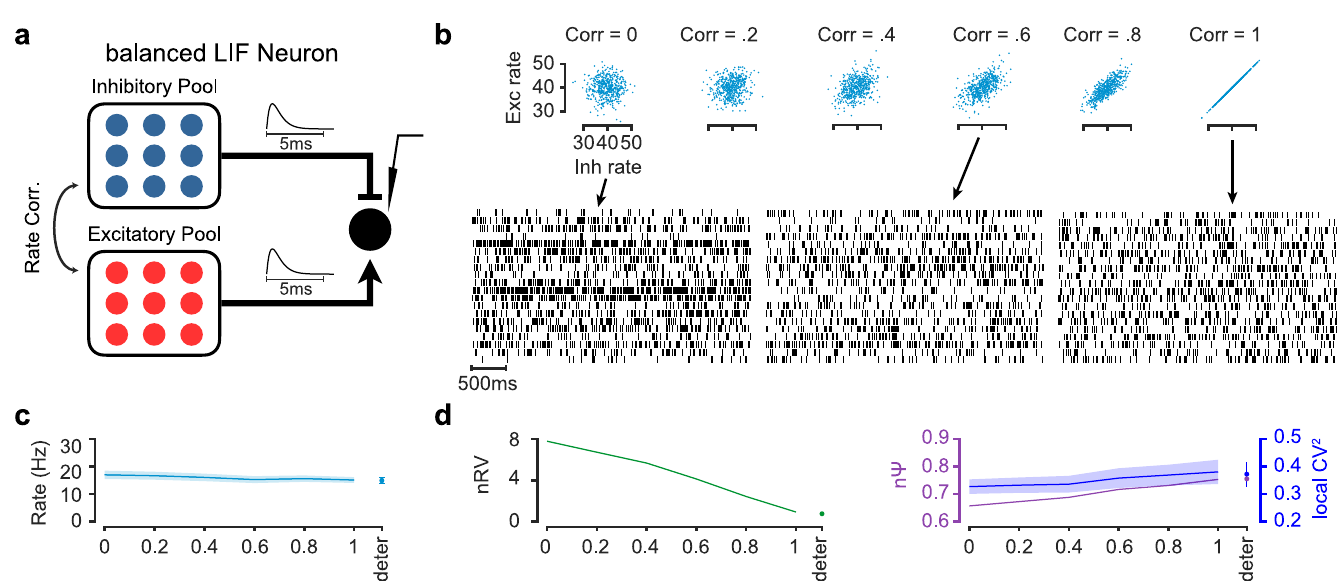
Fig 7. Firing rate correlation between balanced presynaptic excitatory and inhibitory pools controls post-synaptic nRV. (a) Schematic of the network model including 50 Excitatory (E pool) and 50 Inhibitory (I pool) Poisson neurons. The synaptic current is modeled using the same kernel for E and I connections. (b) E/I rate distributions of different trials (~ N (40,4)) with different correlation values (top) along with simulated sample rasters in three correlation conditions (correlations equal to 0, 0,6 and 1). (c) The effect of E/I rate correlation on the firing rate of post synaptic neuron. (d) The effect of E/I rate correlation on the nRV (left) and n C (right) of the post synaptic neuron. The effect on CV 2 is shown alongside n C . Higher rate correlation lead to lower nRV in the post-synaptic neuron but had local minimal effect on n C or CV 2 . Firing rate, nRV, n C and CV 2 for nonrandom presynaptic firing rate (deter) is shown alongside for comparison in c-d. Error bars local local and shades are sem.